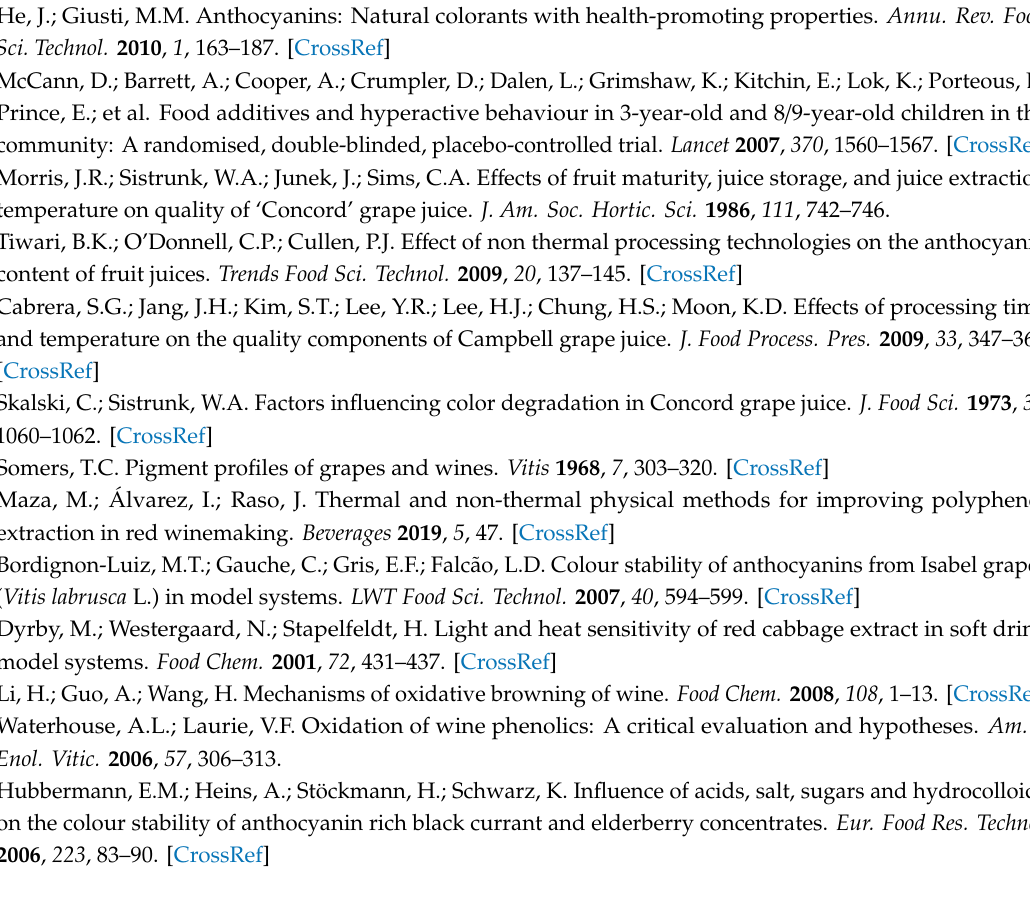
Figure S1. Flowchart of conventional must heating vs. flash d é tente processes for production of Rubired concentrate; Figure S2. Fitted means for interaction plot for 5-hydroxymethylfurfural (5-HMF) in Rubired concentrate from conventional must heating (CMH) vs. flash d é tente (FD), heated at 50 ◦ C; α = 0.05; n = 2. All data normalized to 68 ◦ Brix and to initial concentration to enable calculation of percentage change; Figure S3. E ff ect of seed tannin, low pH, and acetaldehyde on 5-hydroxymethylfurfural (5-HMF) formation in Rubired concentrate from conventional must heating (CMH) at di ff erent temperatures. All data normalized to 68 ◦ Brix. Note the di ff erent y-axis scales; Figure S4. E ff ect of seed tannin, low pH, and acetaldehyde on caftaric acid concentration in Rubired concentrate from conventional must heating (CMH) at di ff erent temperatures. All data normalized to 68 ◦ Brix; Figure S5. Change in proanthocyanidin concentration during accelerated aging of Rubired concentrate from conventional must heating (CMH) at di ff erent temperatures. Note the di ff erent y-axis scales; Figure S6. Change in gallic acid concentration during accelerated aging of Rubired concentrate from conventional must heating (CMH) at di ff erent temperatures. All data normalized to 68 ◦ Brix. Note the di ff erent y-axis scales; Table S1. Comparison of 5-hydroxymethylfurfural (5-HMF) concentrations in Rubired concentrate from conventional must heating (CMH) vs. flash d é tente (FD), after nine days of accelerated aging at di ff erent temperatures; Table S2. Sediment composition of concentrate from conventional must heating after 12 days of accelerated aging at 70 ◦